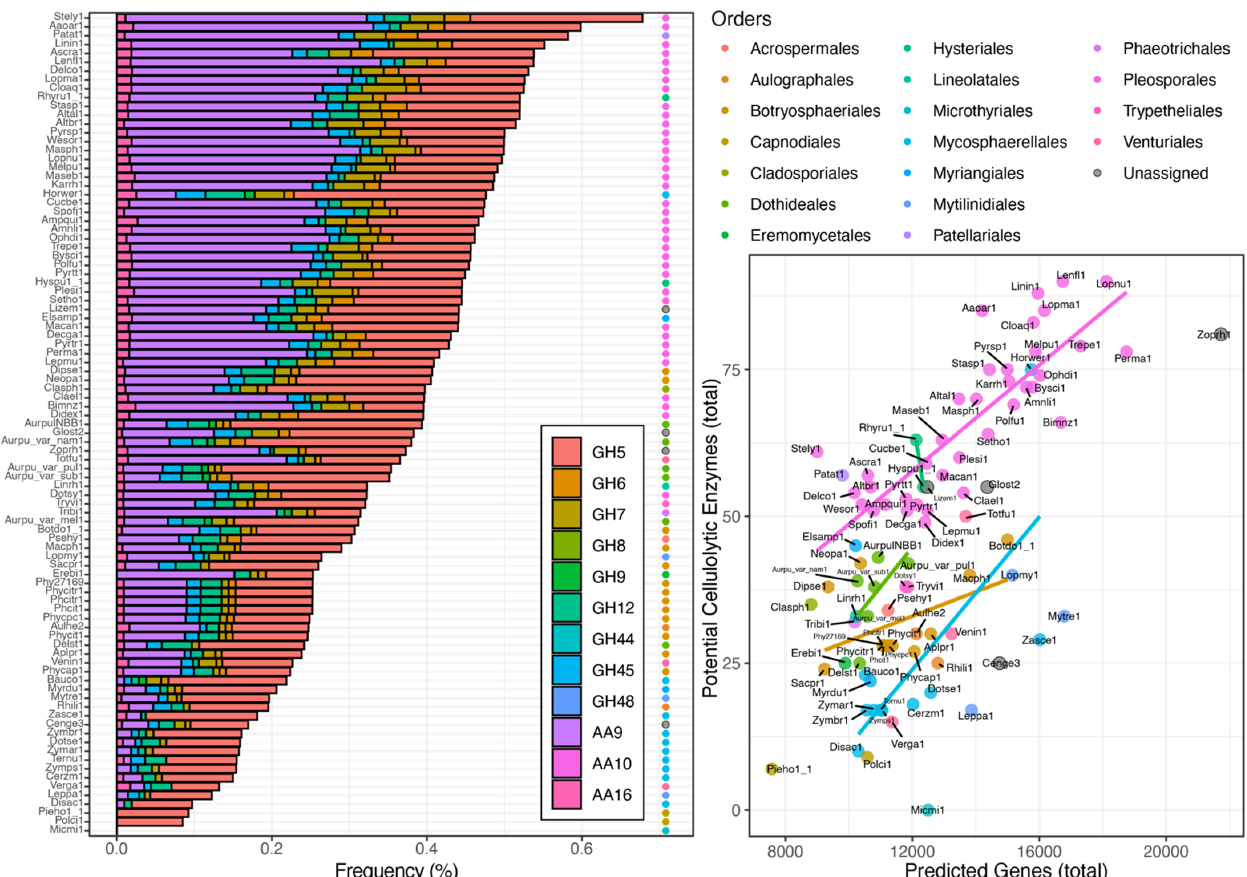
Figure 5. The functional potential for cellulose deconstruction in sequenced genomes from the class Dothideomycetes ( n = 93). Frequency of the predicted potential cellulases (left) and total number of predicted potential cellulases across orders of Dothideomycetes (right). Lines depict the linear regression between the predicted cellulases and the predicted number of genes, if correlated (i.e., P Pearson < 0.05).